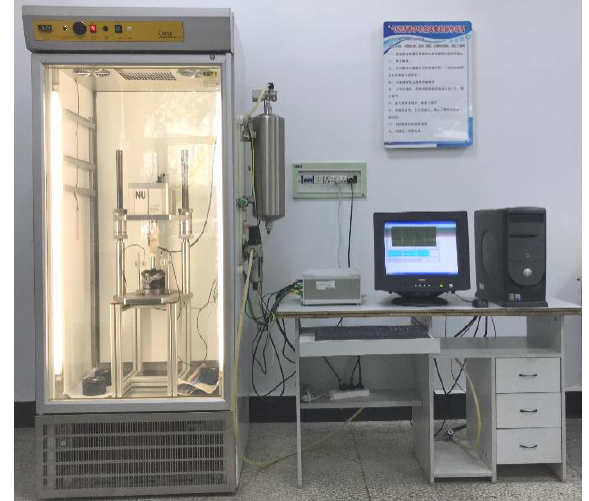
Figure 5. Uniaxial static compression creep test in this paper.